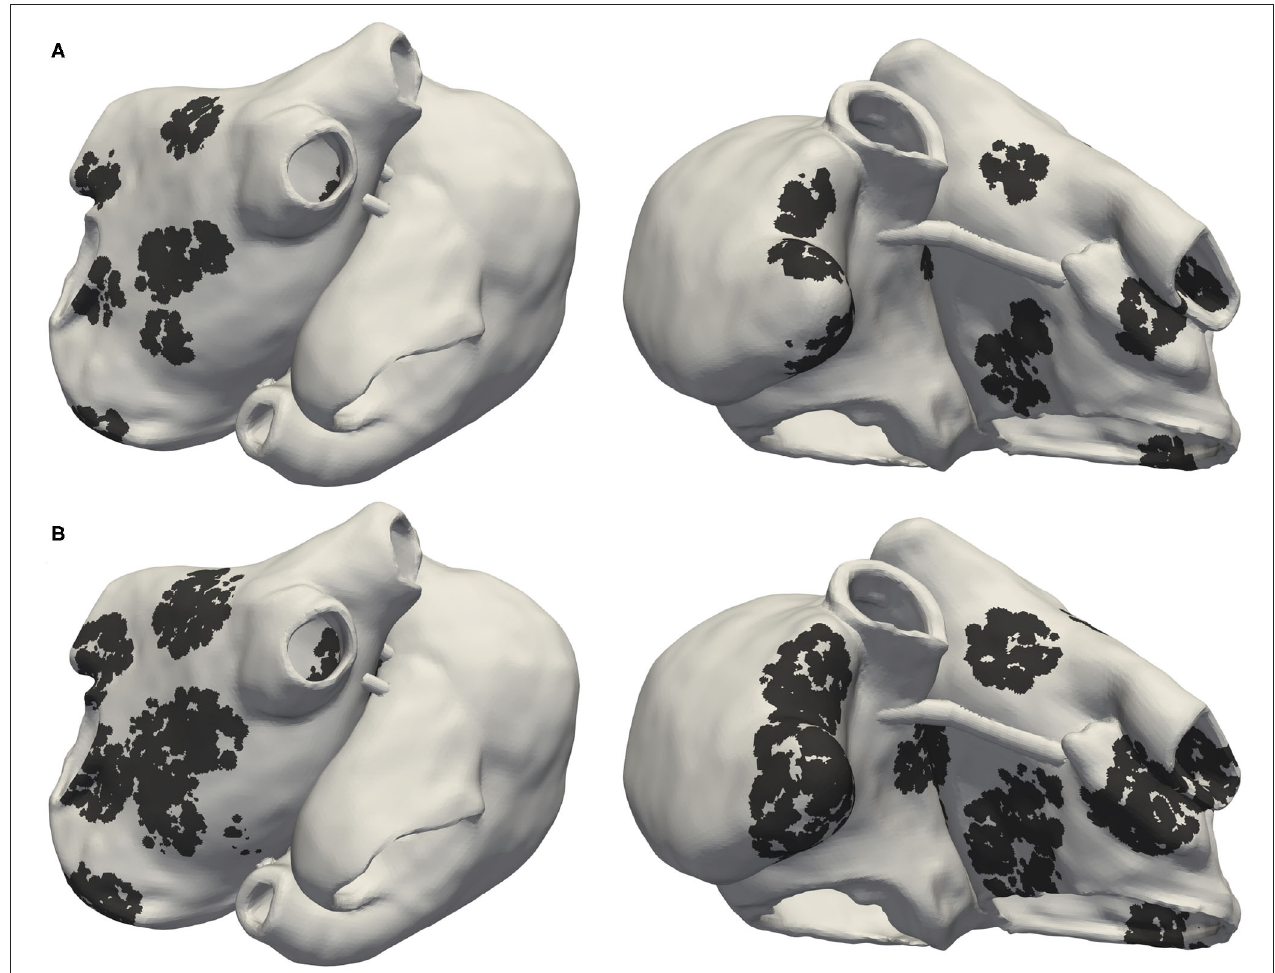
FIGURE 1 | Posterior and anterior view of Utah stage II (UII) model in (A) and Utah stage IV (UIV) model in (B) . Black regions indicate fibrotic tissue in which 50% of the elements were non-conductive and the remaining 50% electrophysiologically remodeled due to cytokine